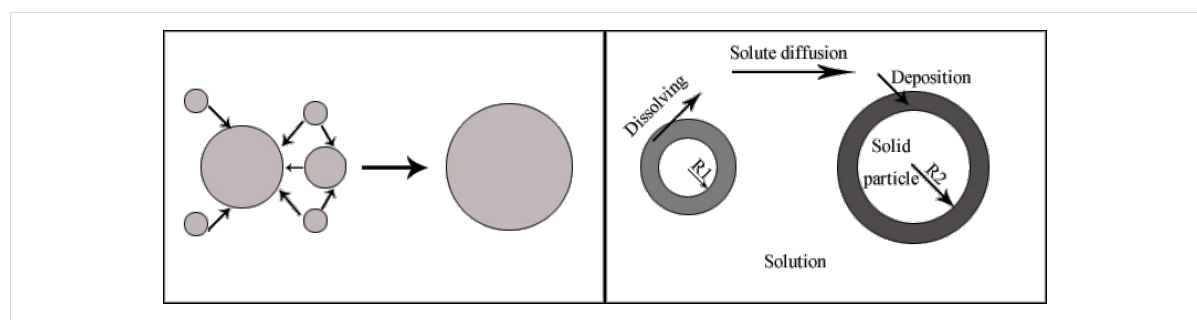
Figure 4: Ostwald ripening: (a) the process of Ostwald ripening involves small particles being engulfed by larger particles; (b) process diagram of Ostwald ripening.